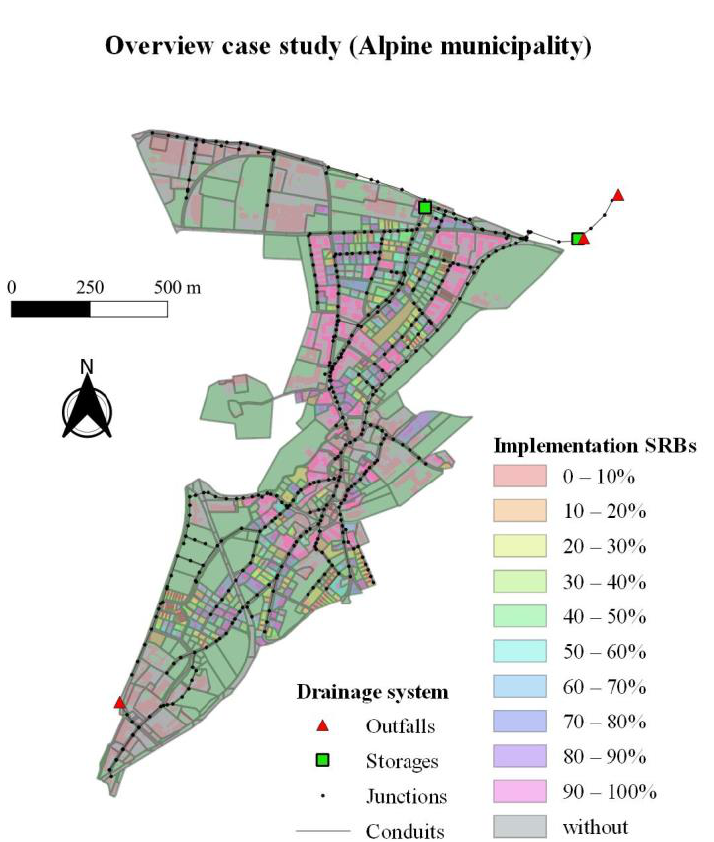
Figure 1. Overview of the Alpine municipality used as the case study with UDN and its associated implementation of SRBs based on roof sizes, starting with the smallest roof area.